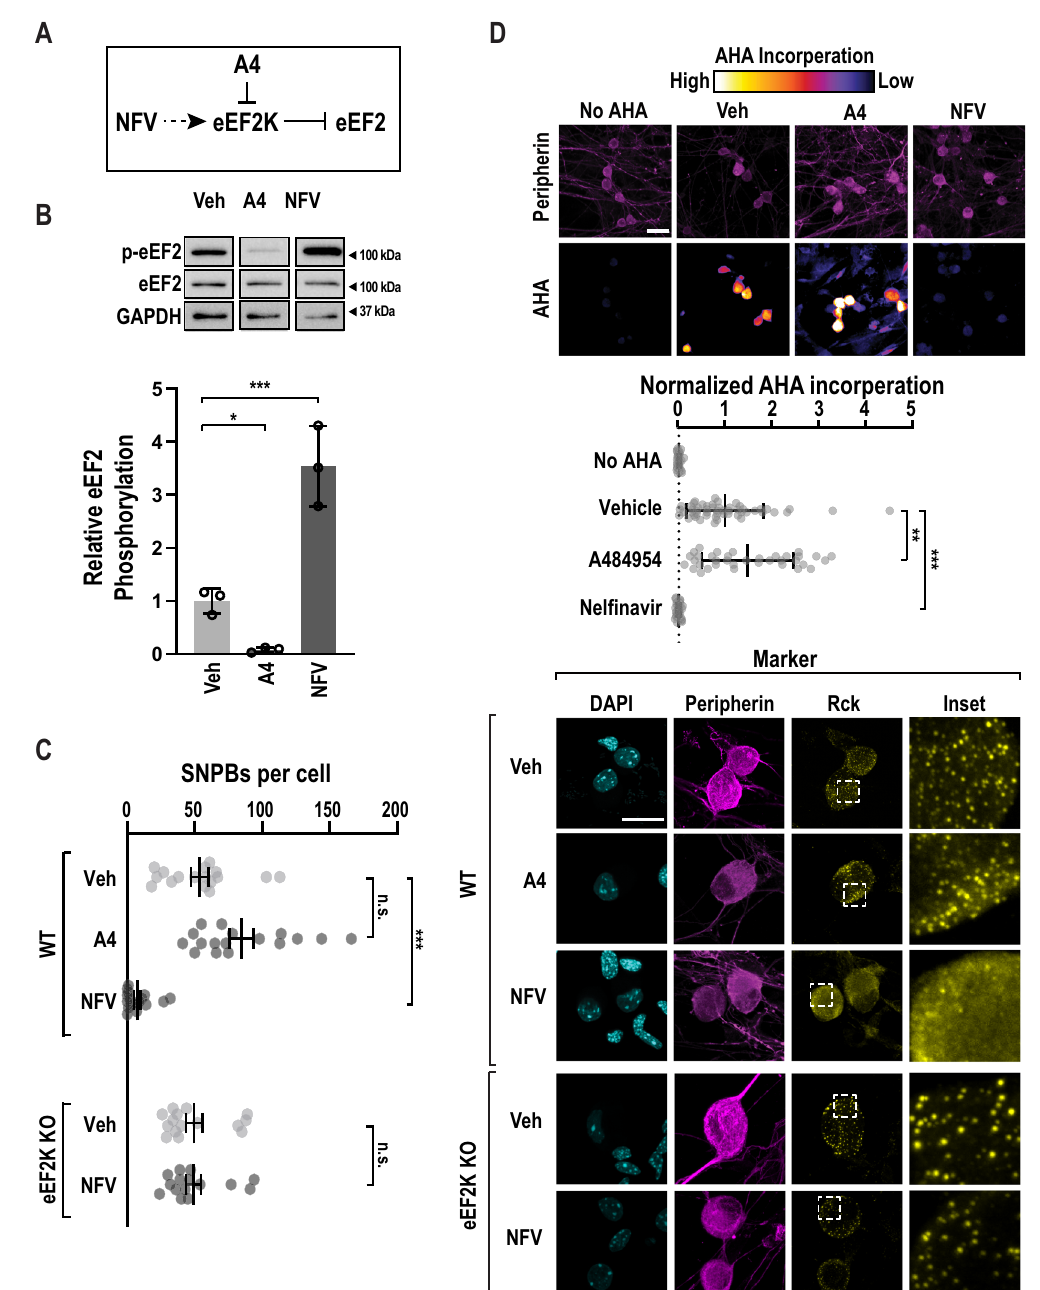
Fig. 2 eEF2K controls p-body numbers in sensory neurons. A A schematic depicting the effects of an eEF2K inhibitor, A484594 (A4), or an eEF2K activator, Nel fi navir (NFV) on eEF2K and eEF2. B Primary DRG cultures were again treated with vehicle (Veh), A484954 (A4, 25 µ M), or nel fi navir (NFV, 50 µ M). Lysates from treated cells were probed for p-eEF2, eEF2, and GAPDH (load control). D upper Representative immunoblots (cropped to depict one representative band per condition). D lower Quanti fi cation represents mean p-eEF2/eEF2 signal, n = 3 biological replicates. Error bars represent ±SD. P -values determined by one-way ANOVA. Veh vs. A4 p = 0.0493, Veh vs. NFV p = 0.0010. C Primary DRG cultures were treated with vehicle (Veh), an eEF2K inhibitor, A484594 (A4), or an eEF2K agonist, Nel fi navir (NFV) for a period of 1 h. As a speci fi city control, NFV, was applied to DRG neurons obtained from eEF2K homozygous loss of function animals ( n = 15). As before, peripherin (magenta) and Rck (yellow) immuno fl uorescence were used to identify neurons and SNPBs, respectively. A left Representative confocal images. Scale bar = 20 µ m. A right Quanti fi cation of SNPBs in peripherin-positive cells. For Veh, A4, and NFV n = 17, 17, and 16 cells, respectively. The error bars represent mean ± S.E.M. p -values determined by one-way ANOVA. Veh vs. NFV p < 0.0001. D Primary WT DRG cultures were treated as in B with the addition of a 30-minute pulse of AHA. As before, cells were subjected to FUNCAT and peripherin immuno-labeling and imaged via confocal microscopy. To quantify the baseline, a control group without AHA was imaged. C upper Representative confocal images. Scale bar = 30 µ m. D lower Quanti fi cation of mean AHA incorporation in peripherin-positive cells, normalized to signal from AHA-free cells. For No AHA, Veh, A4, and NFV n = 30, 53, 36, and 28 cells, respectively. Bars indicate mean ± SD p -values determined by one-way ANOVA. Veh vs. A4 p = 0.0016, Veh vs. NFV p < 0.0001. Source data are provided as a Source Data fi le. Uncropped blots are presented in